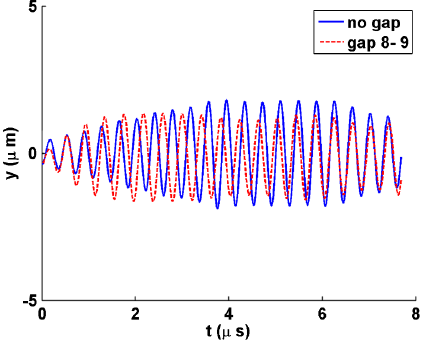
train.FIG. 16. Oscillation of an ion cloud ( y -component) interacting with a full bunch train and a bunch train with two gaps at each 8th and 9th position of the train.